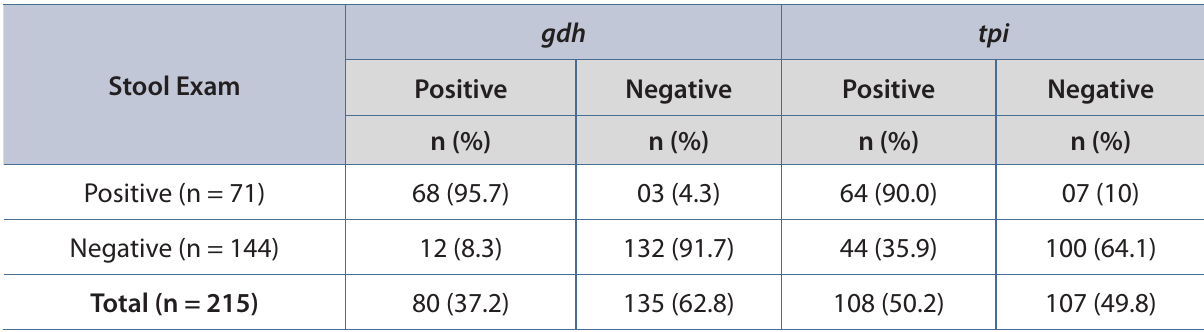
Table 3 . Amplification of gdh and tpi Giardia genes from 215 stool samples, microscopically positive (71) and negative (144), obtained from children in São Paulo state, Brazil